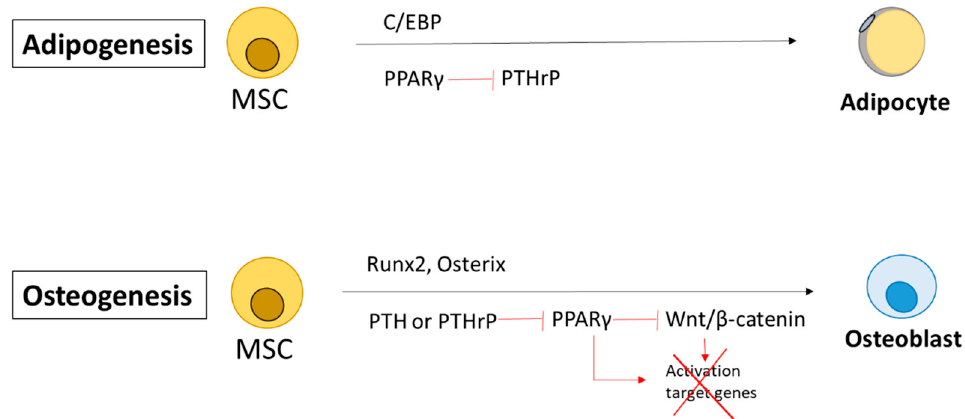
Figure 1. Reciprocal relation between PTHrP and PPARgamma in adipogenesis and osteogenesis. Adipogenesis requires activation of C/EBP and PPAR γ , and PPAR binds to Pthlh promoter regions as a repressor. Osteogenesis requires activation of transcription factors such as Wnt/ β‐ catenin, Runx2, and Osterix. C/EBP: CCAAT/enhancer binding protein MSCs: mesenchymal stem cells; PTHrP: Parathyroid hormone ‐ related protein; RunX2: Runt ‐ related transcription factor 2.